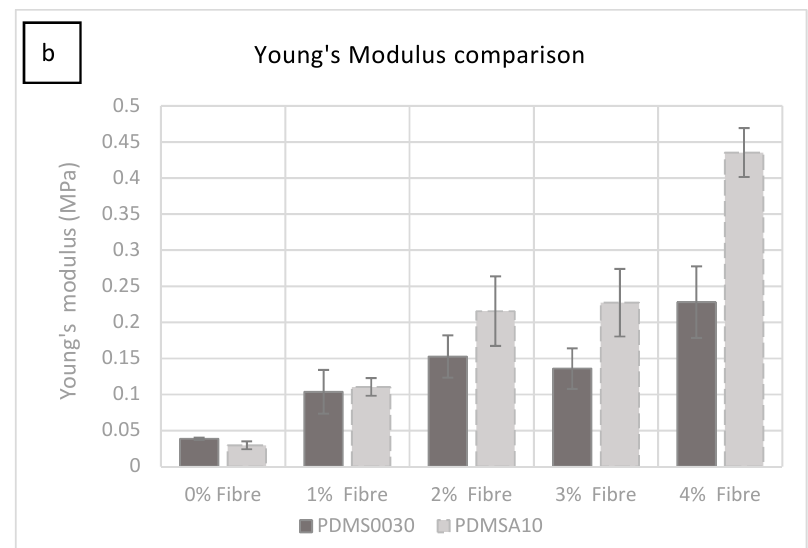
Figure 2. ( a ) The ultimate tensile strength comparison or force taken to rupture the specimen, given in MPa for each specimen group of PDMS A-10 and PDMS 00-30 composites with 0%–4% fibre addition. The error bars represent the standard deviation in each group. ( b ) Average Young’s modulus comparison for each specimen sample group with 0%–4% fibre addition. The error bars represent the standard deviation in each group.